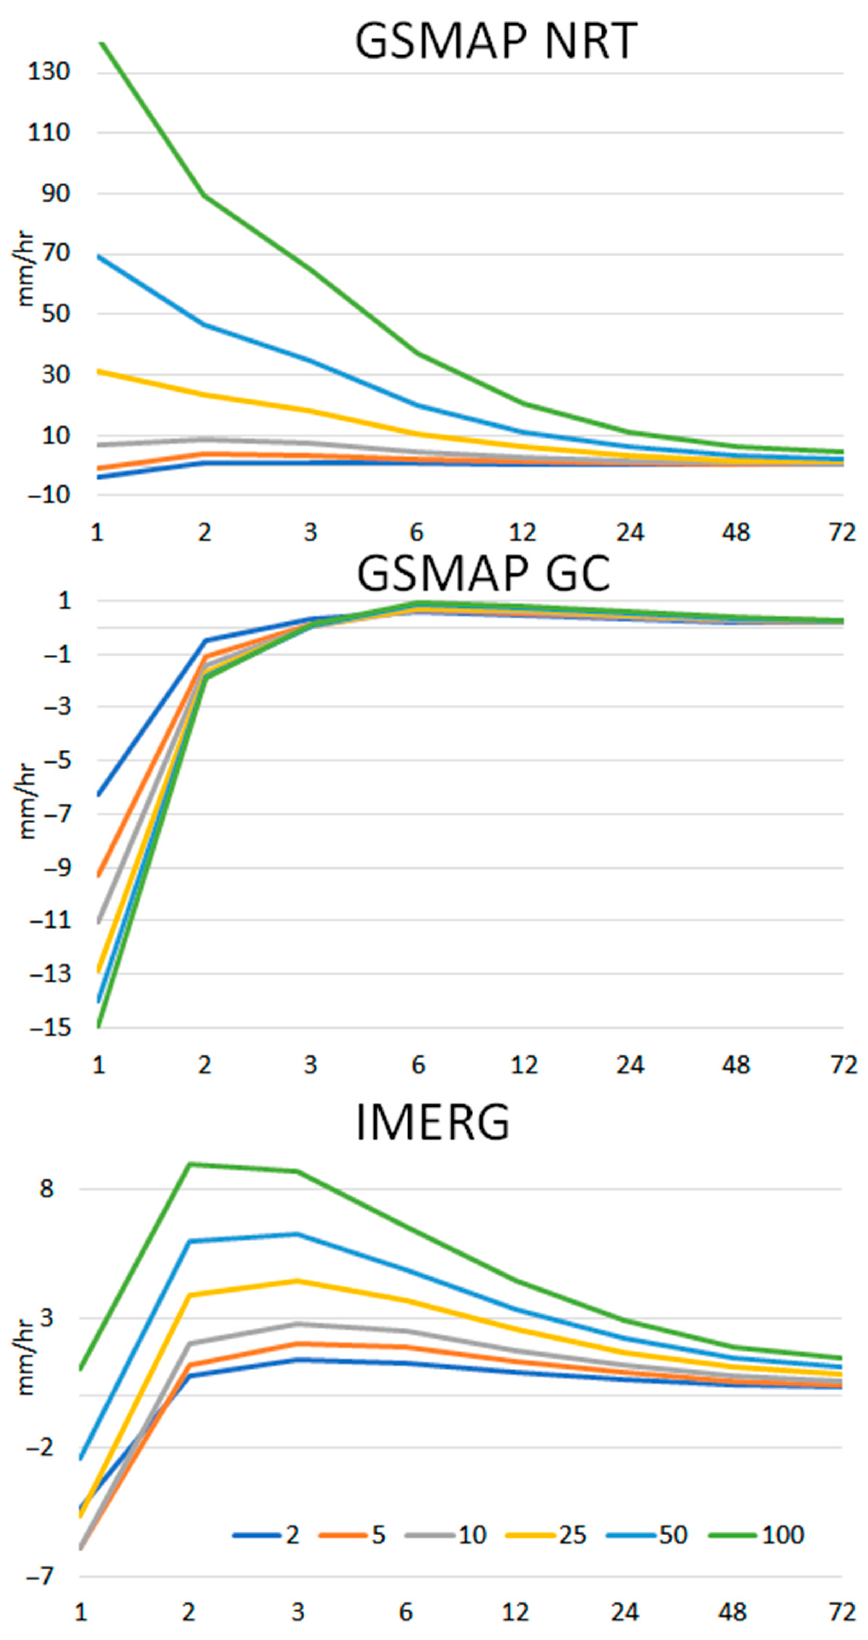
Figure 11. Bias in IDF curves in GSMaP NRT, GSMaP GC, and IMERG data compared to observation at Basrah.